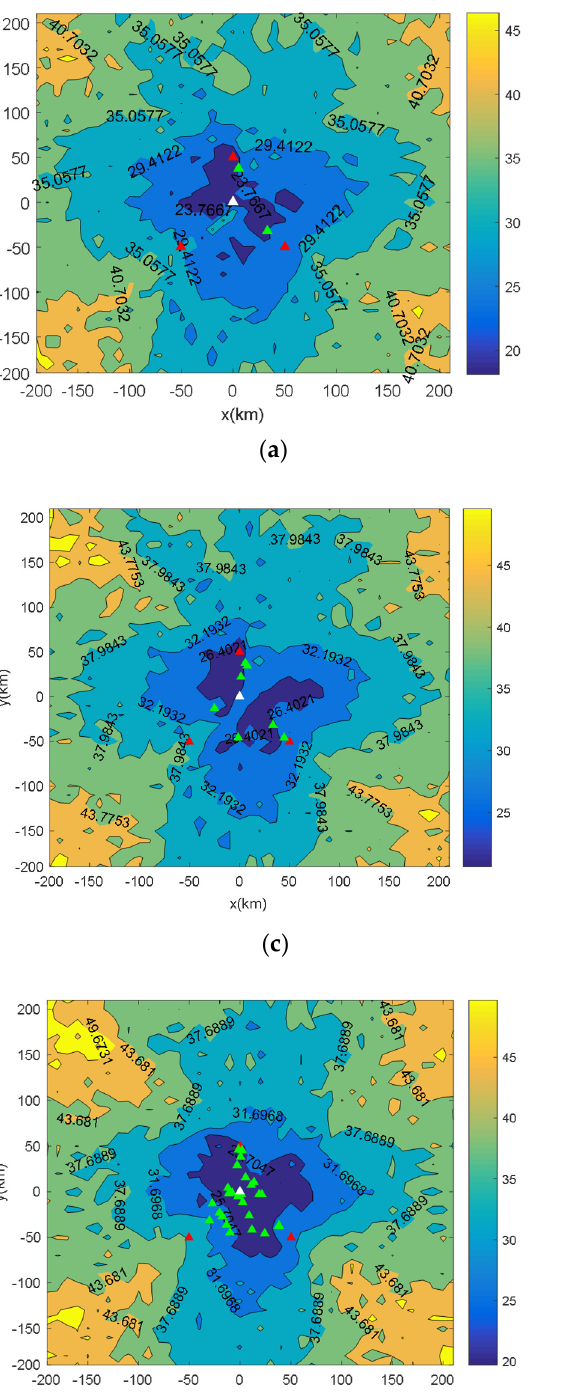
ceivers. The location errors under the 100 × 100 × 100 m grid step. The triangles indicate the re- ceivers’ locations. The white triangle shows locations at the origin, and the three red triangles form a triangle that covers the others, whose color is green.